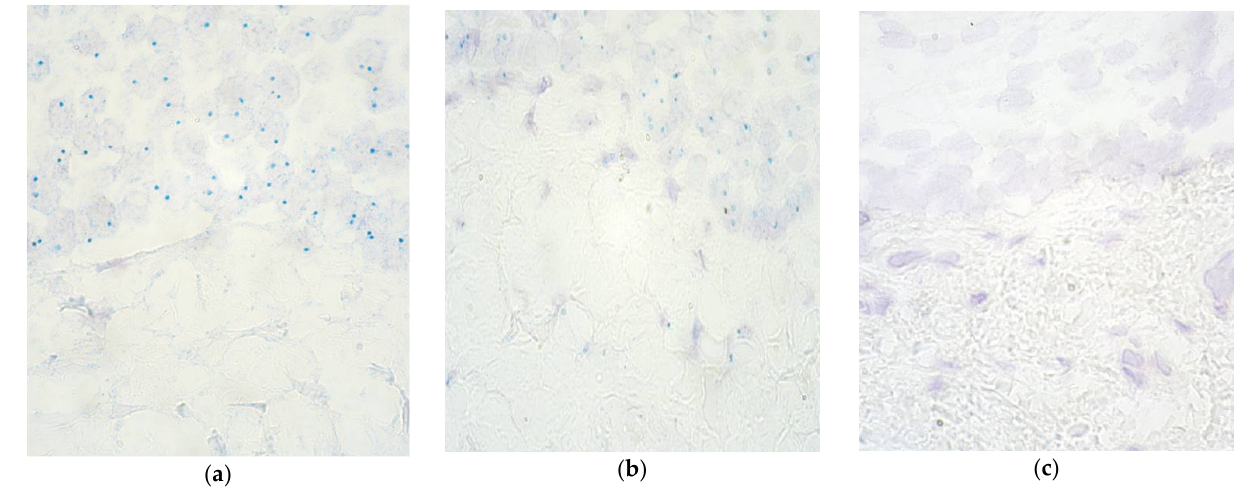
Figure 1. Chromogenic in situ hybridization micrographs of FGFR1 in cleft-affected lip and palatine tissue and control subject at 1000× magnification, using immersion oil. ( a ) Numerous (+++) gene signals in lip epithelium and no gene copies in lip connective tissue in a 3.5-month-old patient. ( b ) Numerous (+++) gene signals in palatine epithelium and a few (+) gene copies in palatine connective tissue in a 10-month-old patient. ( c ) No (0) gene signals in the control group epithelium and connective tissue of a 10-year-old child. The majority of epitheliocytes in the lip and vomer mucosa (6 out of 10 and 7 out of 10, respectively) contained the FGFR2 gene, ranging from occasional copies (0/+) to numerous (+++) (Table 2, Figure 2a,b). In the connective tissue and endothelium of lip and vomer mucosa, the range of observed FGFR2 signals was the same (from 0 to +/++). However, more lip tissue samples had 0 gene signals in connective tissue (7 out of 10) and endothelium (8 out of 10) compared to palatine (5 out of 10 and 7 out of 10, respectively). In the control group, the range of observed FGFR2 signals in the epithelium was the same as in the study group; however, it was narrower in the connective tissue and endothelium with the highest value of 0/+ and +, respectively (Figure 2c).